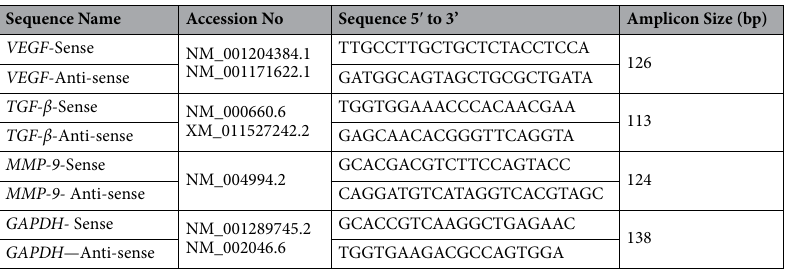
Table 1. The VEGF, TGF-β, MMP-9 and GAPDH primers sequences. IGF-1: Insulin-like growth factor-1; HGF: Hepatocyte growth factor; GAPDH: Glyceraldehyde-3-phosphate dehydrogenase; bp: Base